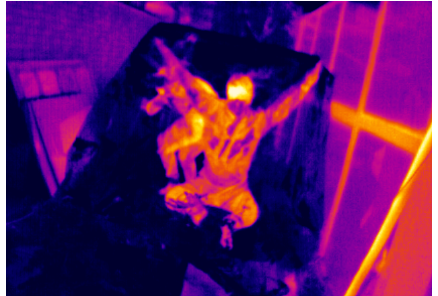
Figure 4. Example of thin-film transmissivity. Source: